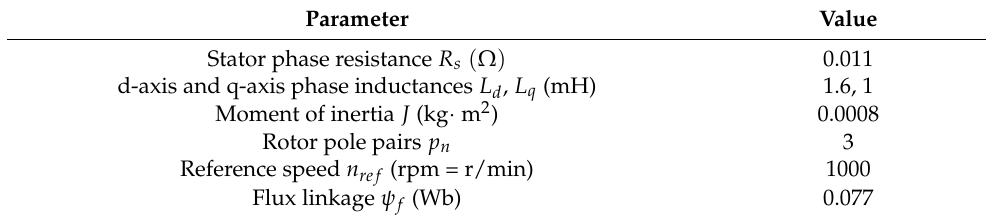
Table 4. The setting of PMSM parameters.